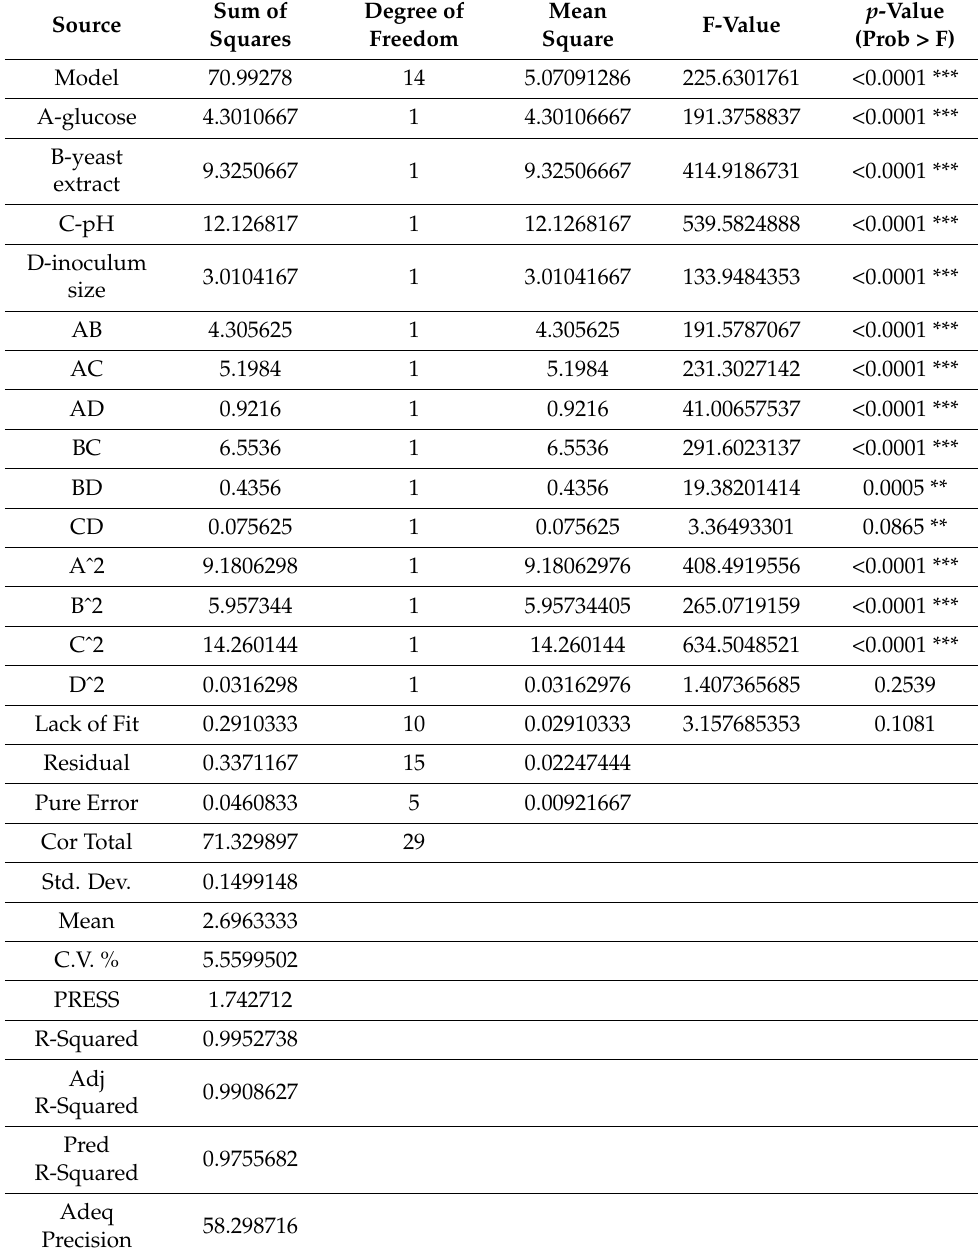
Table 2. Analysis of variance of a quadratic optimization model for EPS production by thermophilic B. haynesii